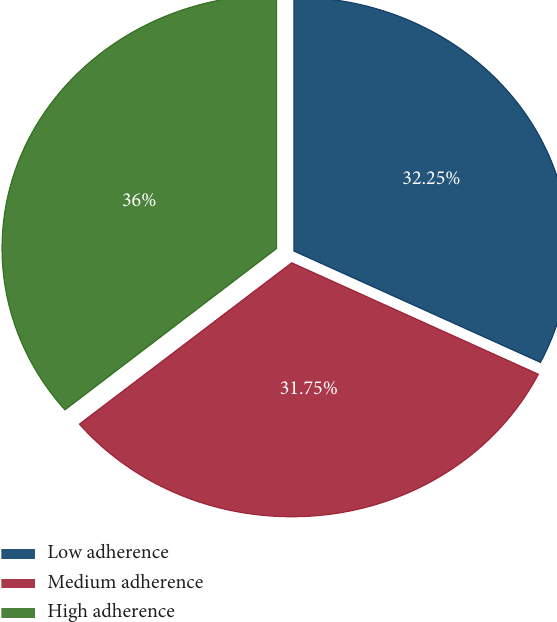
Table 6: Responses of hypertensive patients to MMAS-8 questions in Central Ethiopia, 2017 ( n � 989).